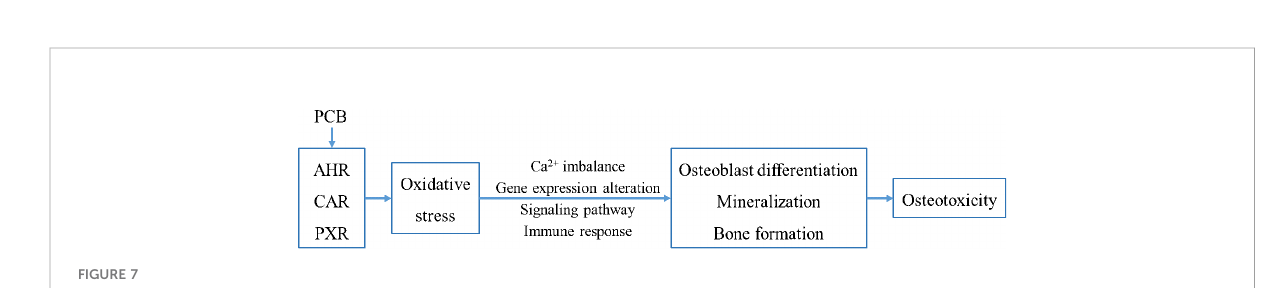
FIGURE 7 The schematic diagram of A1254-induced